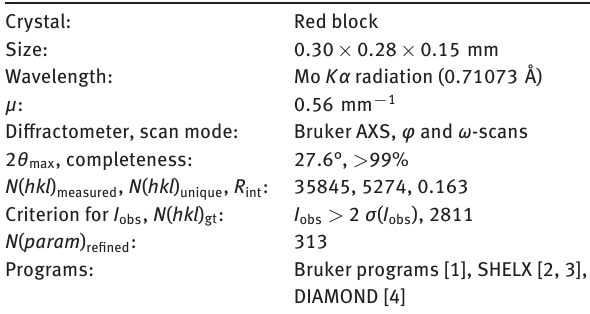
Table 1: Data collection and handling.